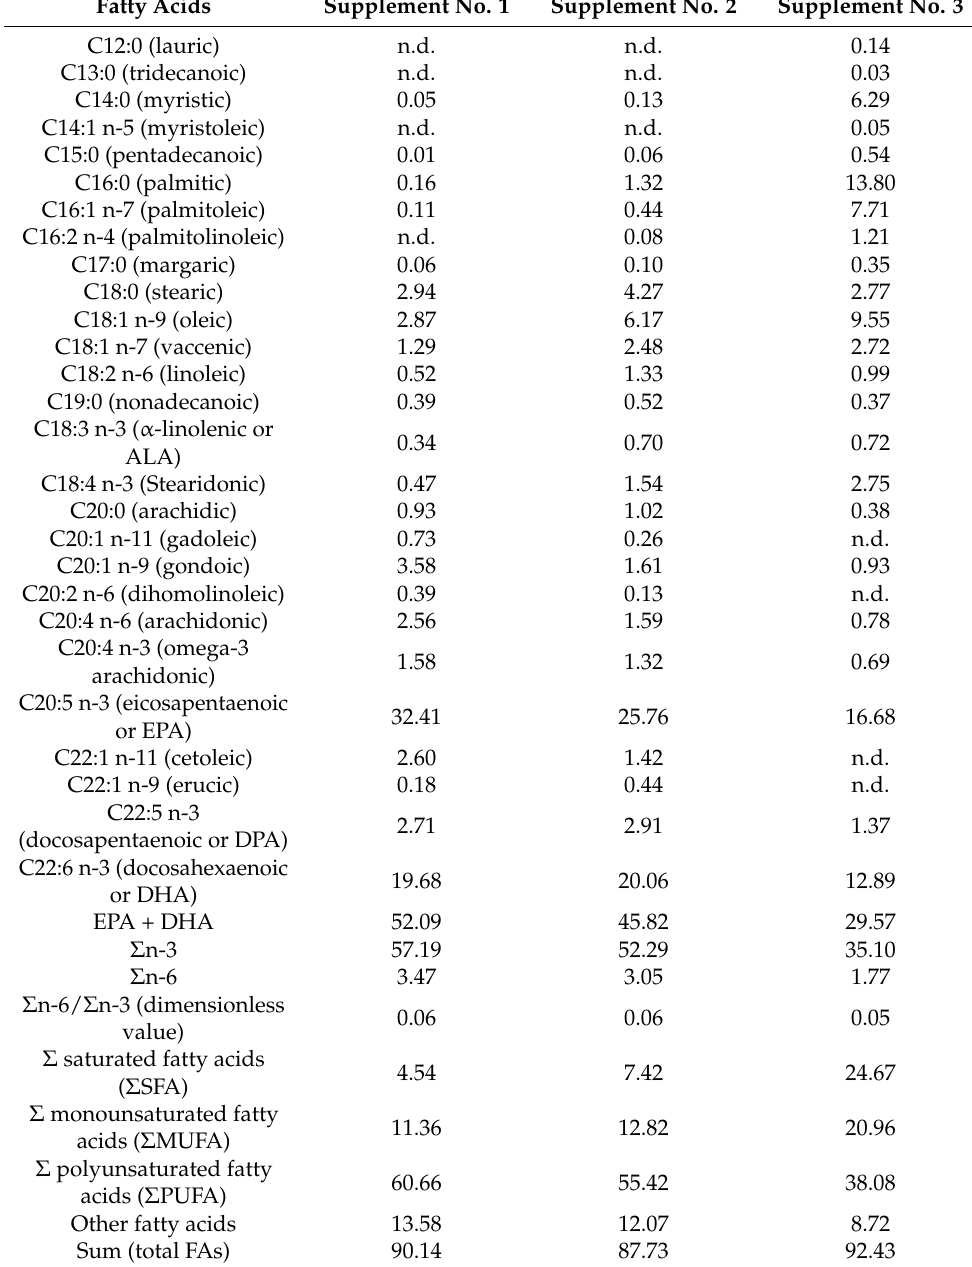
Table 1. Fatty acid composition of the three dietary supplements analyzed (mg/100 mg oil). Fatty Acids Supplement No.